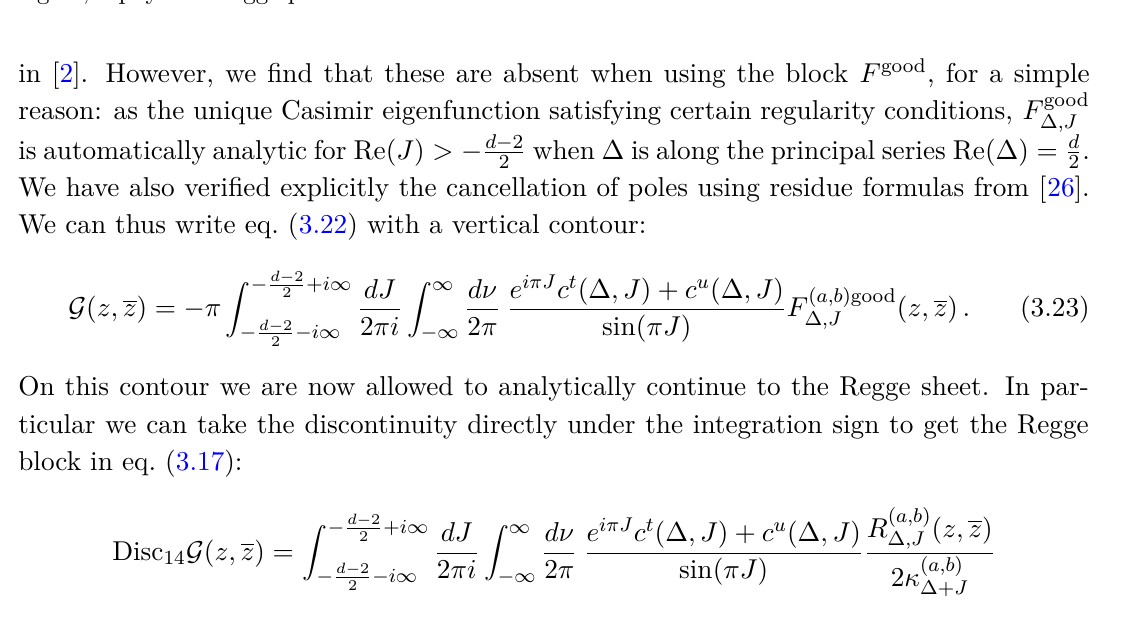
Figure 8 . Spurious poles of type 2-3 cancel against each other just as in the S-matrix case (figure 5). Again, a physical Regge pole is shaded